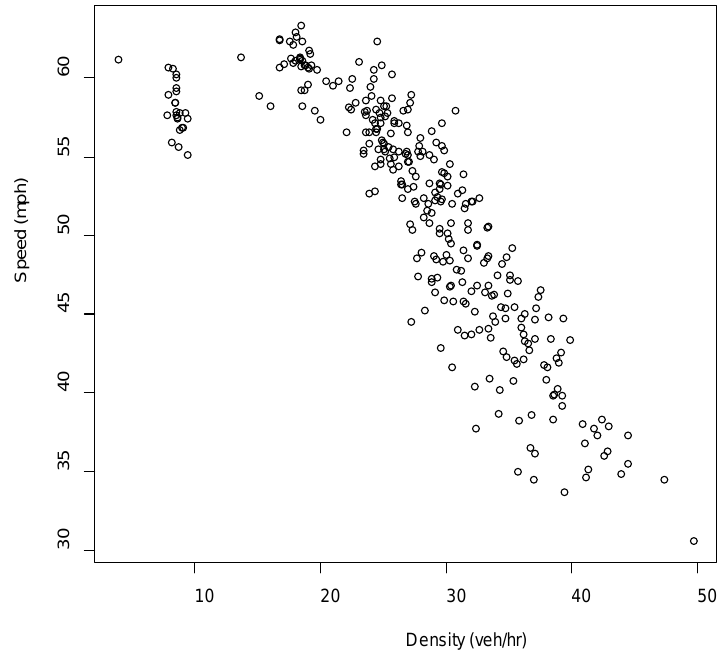
Figure 5. Case study II truck speed-density plot Two